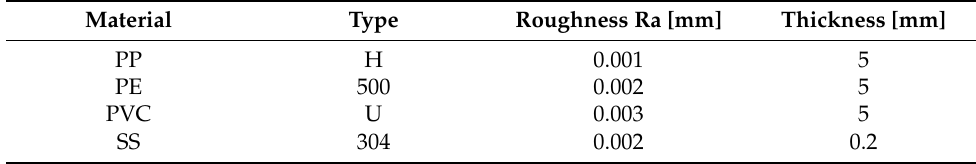
Table 2. The characterization of the used